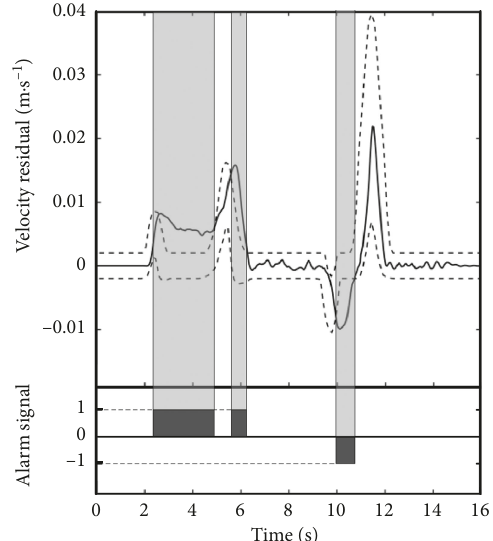
Figure 8: Residuals of angular sensor fault and alarm signal.